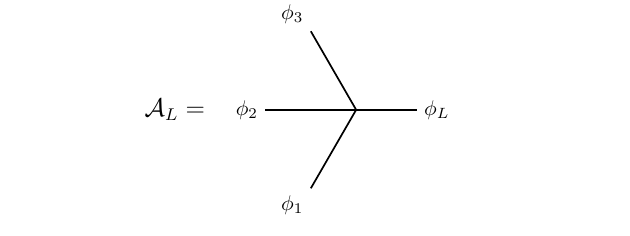
Figure 3 . Four-point vertex appearing on the left-hand-side of a 6-point NLSM exchange